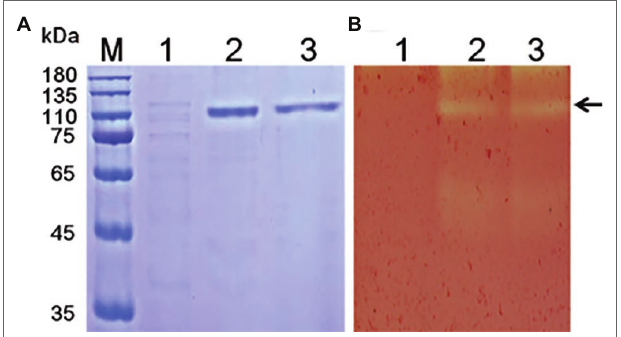
FIGURE 1 | SDS-PAGE (A) and zymogram (B) analysis of Tk-ChiA from T. kodakarensis KOD1. Lane M, protein marker (GenStar, Beijing); Line 1, crude extract of P. pastoris GS115 transformed empty plasmid (pPIC9K); Lane 2, crude protein extract from the supernatant of the recombinant strain transformed pPIC9K -Tk1765 plasmid; Lane 3, purified recombinant Tk-ChiA. The arrow indicates the position of